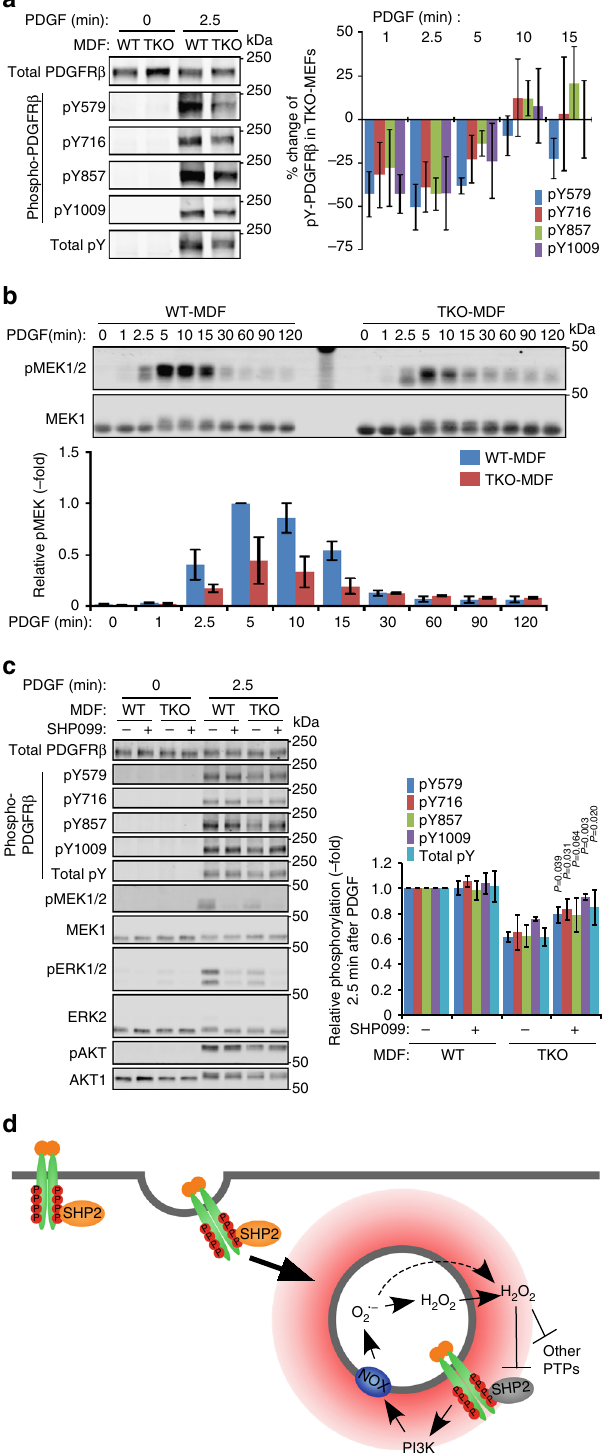
marker calnexin (Supplementary Fig. 7e). The speci fi city of each of these antibodies for their respective NOX protein was